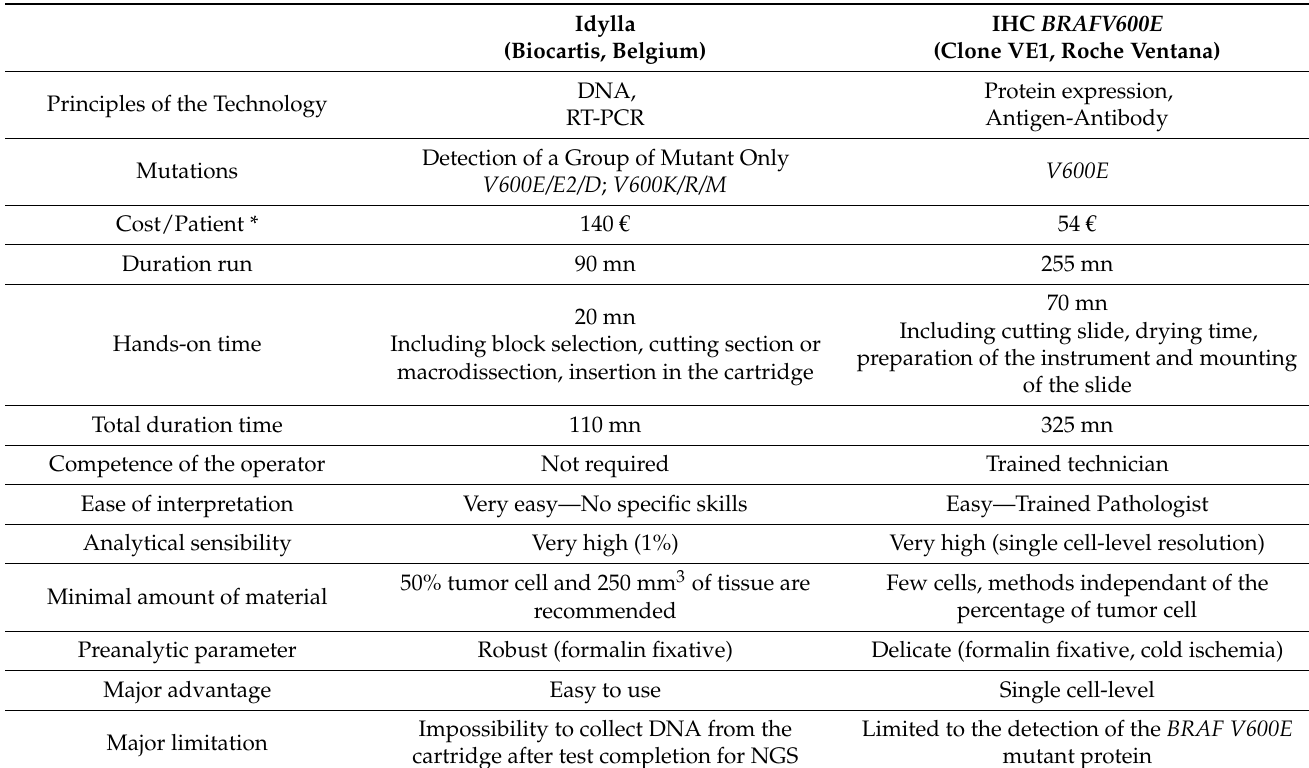
IHC BRAFV600E (Clone VE1, Roche Ventana) Protein